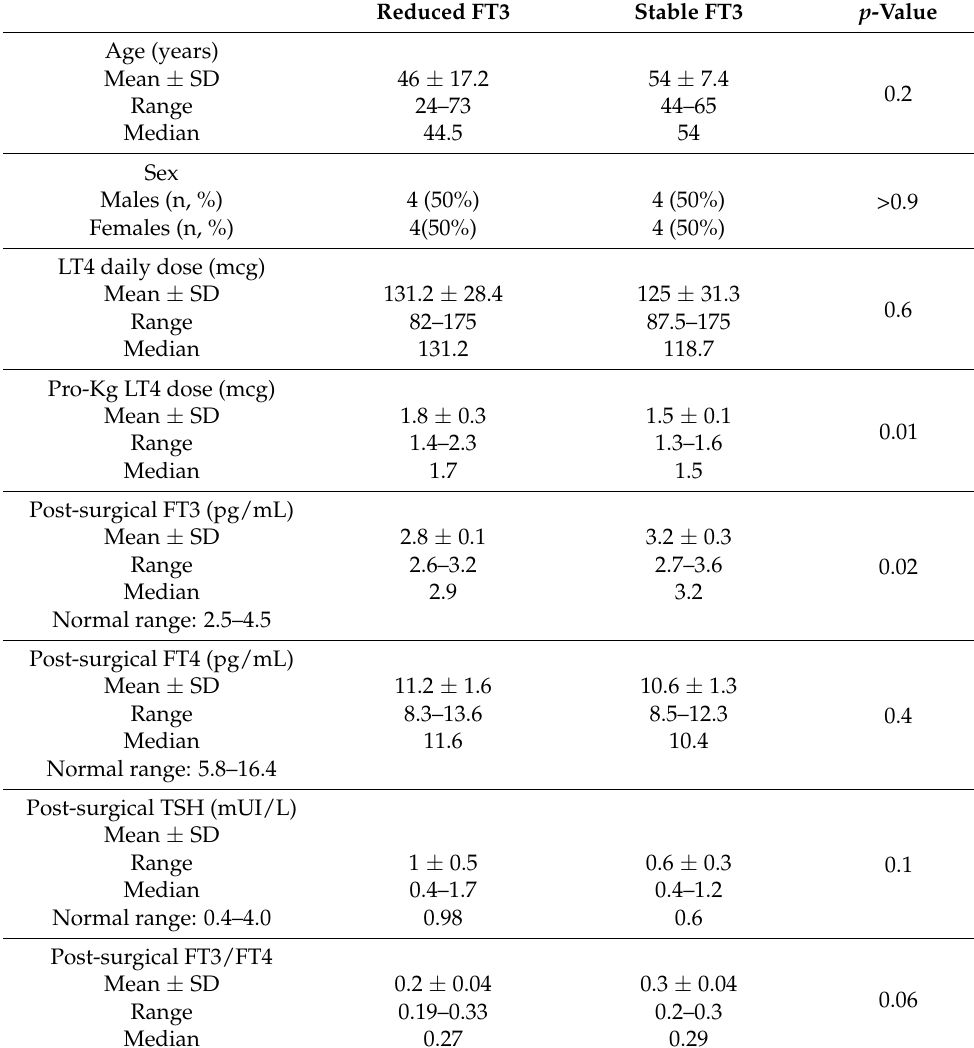
Table 1. Patients’ demographic data and comparison of post-surgical thyroid hormone levels between “reduced FT3” and “stable FT3” patients. Reduced FT3 Stable